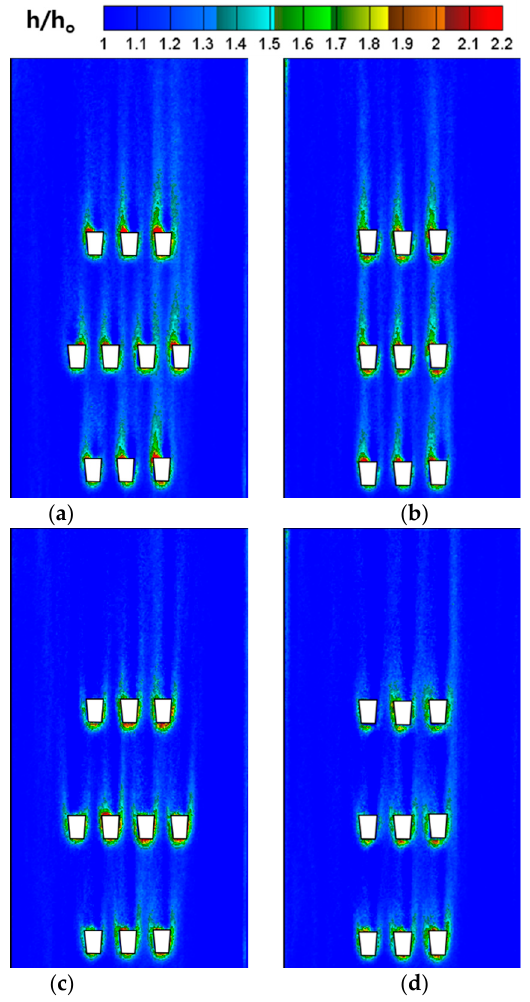
Figure 13. Distribution of h/h o for selected hole arrangements ( a ) staggered, M = 1.0; ( b ) inline, M = 1.0; ( c ) staggered, M = 2.0; and ( d ) inline, M = 2.0.